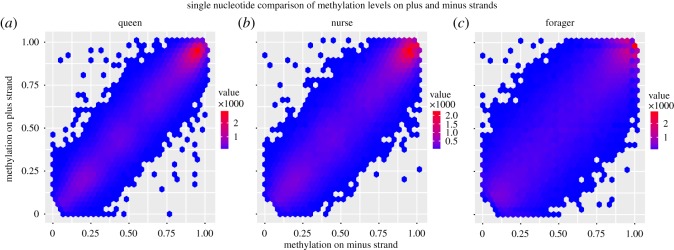
Comparison of methylation levels in (a) queen, (b) nurse and (c) forager datasets. Methylation levels were strongly correlated in each functional category, with the majority of points showing symmetrical methylation levels and a small proportion of asymmetrical sites (Rqueen2 = 0.93, Rforager2 = 0.84, Rworker2 = 0.90, Pearson's correlation).